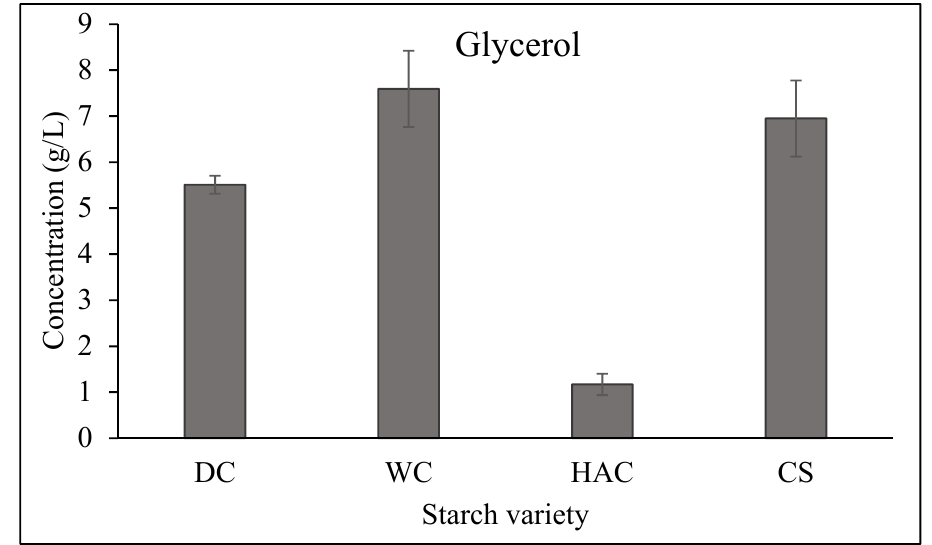
Figure 7. Final concentration of glycerol with four starch varieties (dent corn (DC), waxy corn (WC), high amylose corn (HAC), and cassava starch (CS)) for GSH (granular starch hydrolysis) process.